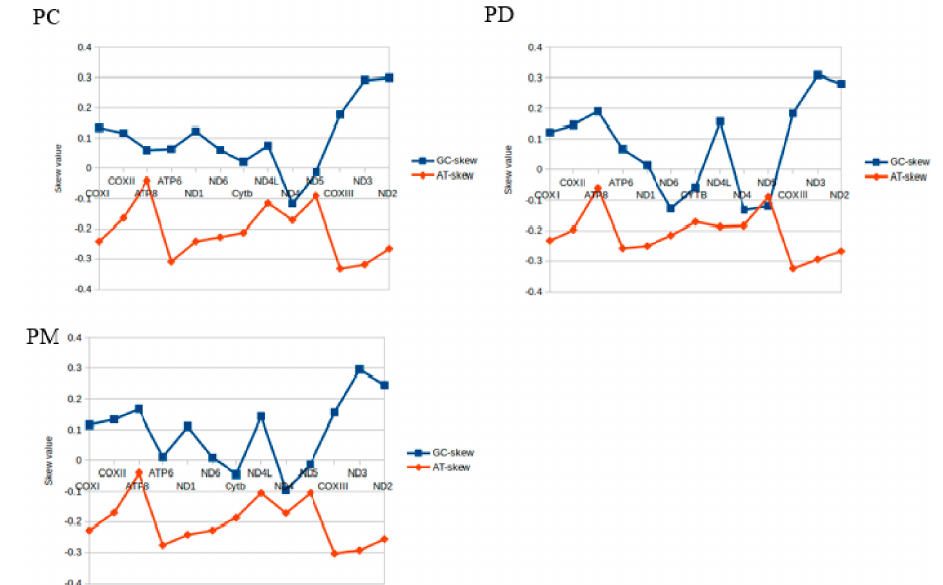
Figure 2. Graphical illustration showing the AT- and GC-skew in the PCGs of the mitochondrial genome of P. canaliculata ( PC ), P. diffusa ( PD ) and P. maculate ( PM ).